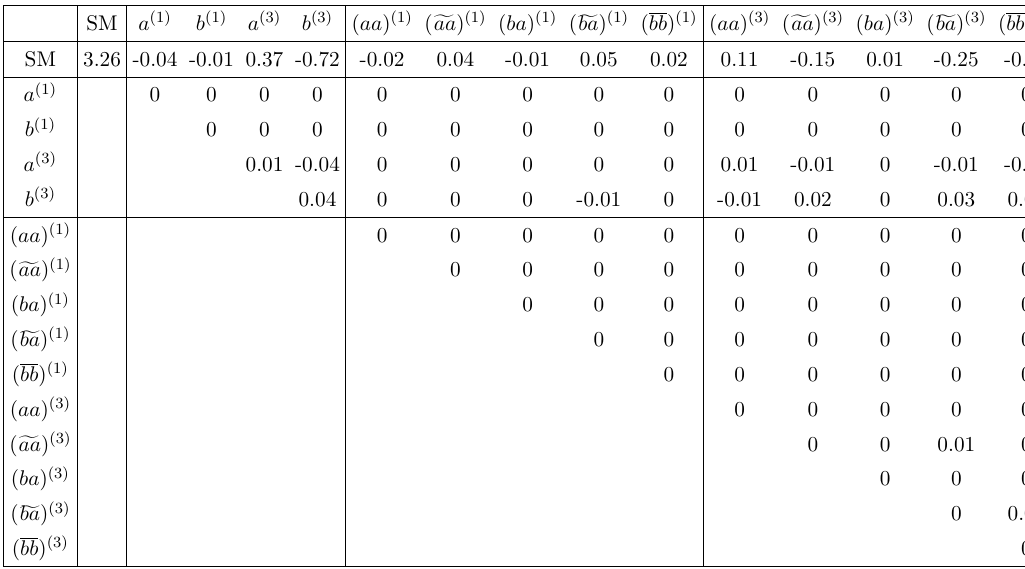
¯ B s → X s γ ) × 10 4 . The reference scale is set to